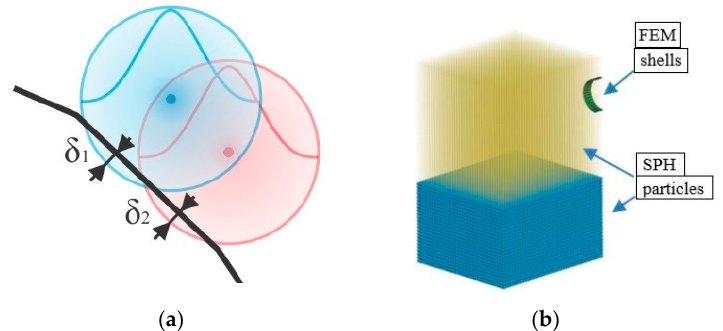
Figure 2. Modeling the contacts: ( a ) shell–particle and particle–particle contacts ( δ 1 and δ 2 as penetration depths); ( b ) finite element method (FEM) shell mesh immerged (the cylinder) in a Smoothed particle hydrodynamics (SPH) environment (air and water).